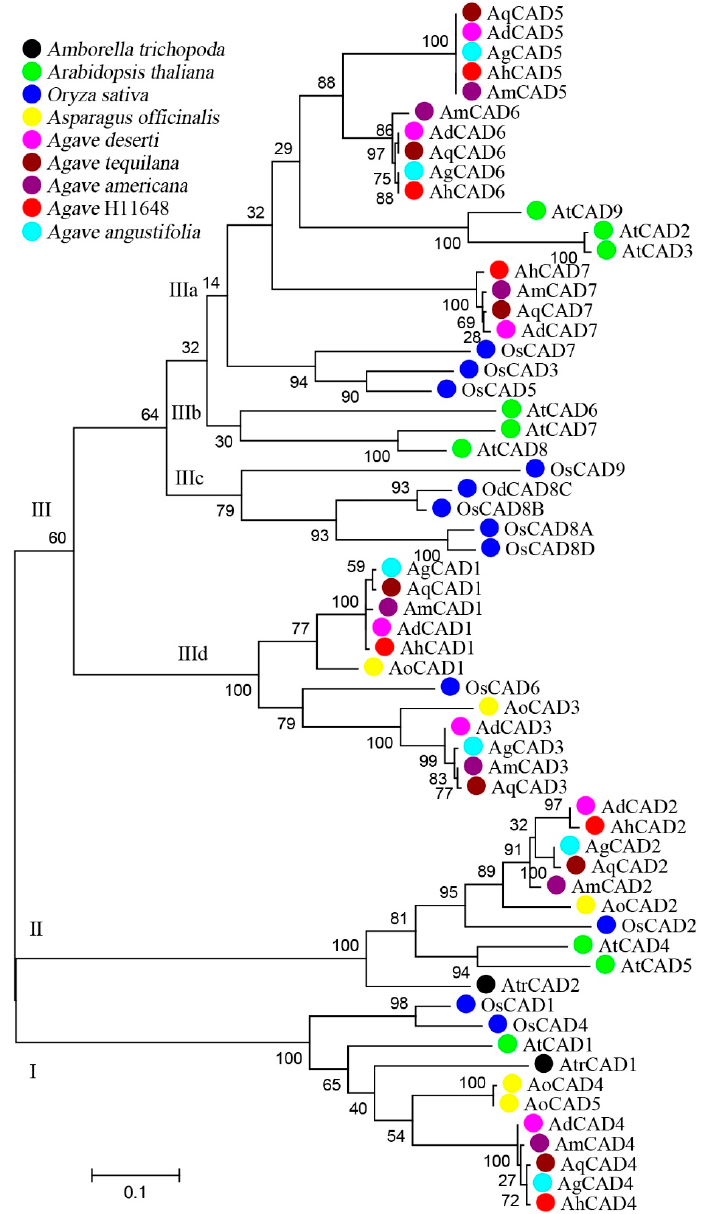
Figure 3. The maximum phylogenetic tree of CAD proteins in amborella (Atr, black), arabidopsis (At, green), rice (Os, blue), asparagus (Ao, yellow), A. deserti (Ad, pink), A. tequilana (Aq, crimson), A. americana (Am, purple), A . hybrid H11648 (Ah, red) and A. angustifolia (Ag, celeste).